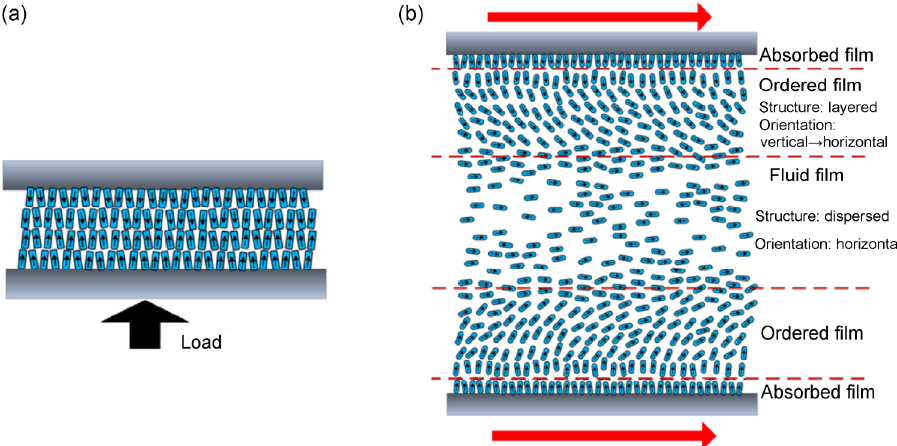
Fig. 14 Molecular models of liquid crystal 5CB (a) in static contact and (b) in TFL, proposed by Zhang et al. [90].